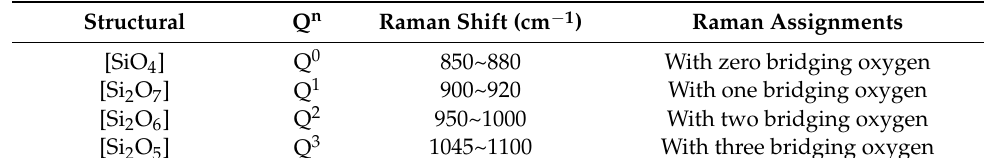
Table 3. Raman shift values of different structures and the Q n values.